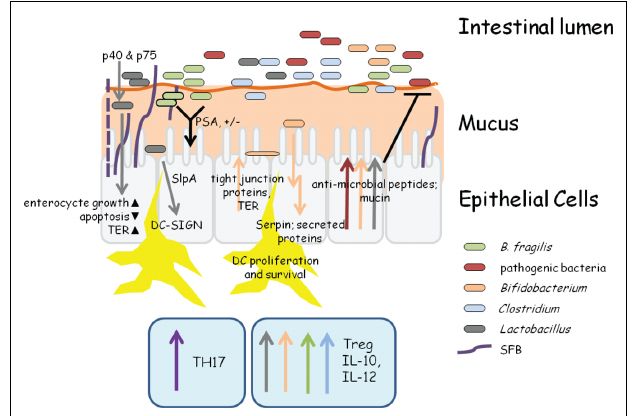
FIGURE 1 | Snapshot of bacterial–host activity in the intestine. This extremely simplistic view of intestinal activity highlights some of the major roles of different bacteria within the intestine. SFB attach to epithelial cells, induce pro-inflammatory responses, and expandTH17 cells (Davis and Savage, 1974; Gaboriau-Routhiau et al., 2009; Ivanov and Littman, 2010). Bacteroides fragilis and many Clostridium species induce IL-10 production and the expansion ofT-regulatory cells (Mazmanian et al., 2005,2008; Atarashi et al., 2011). In B. fragilis , this is mediated through the surface polysaccharide, PSA (Mazmanian et al., 2008). Both Lactobacillus and Bifidobacterium can induce anti-inflammatory cytokine production, anti-microbial peptide, and mucin production, and may adhere to epithelial cells (Adlerberth et al., 1996; Pretzer et al., 2005; Kleerebezem et al., 2010; Sanchez et al., 2010;Turpin et al., 2010).The secreted proteins, p40 and p75 from many Lactobacillus species promote cell growth through a PI-3K and AKT pathway, inhibit apoptosis by causing decreasedTNF α levels, and increase transepithelial resistance (TER) through increased tight junction protein production (Yan et al., 2007; Seth et al., 2008). Lactobacillus S-layer protein A (SlpA) binds to DC-SIGN which leads to increased IL-10 production. SlpA can bind directly to epithelial cells, which may play a role in colonization resistance (CR) against pathogenic bacteria (Antikainen et al., 2002; Chen et al., 2007).The Bifidobacterium serine protease inhibitor Serpin inhibits neutrophil elastase, thereby modulating acute inflammation in the intestine (Ivanov et al., 2006). Finally, undefined secreted proteins from Bifidobacterium species cause an increase in tight junction protein production and therebyTER, contributing to CR (Sanchez et al.,